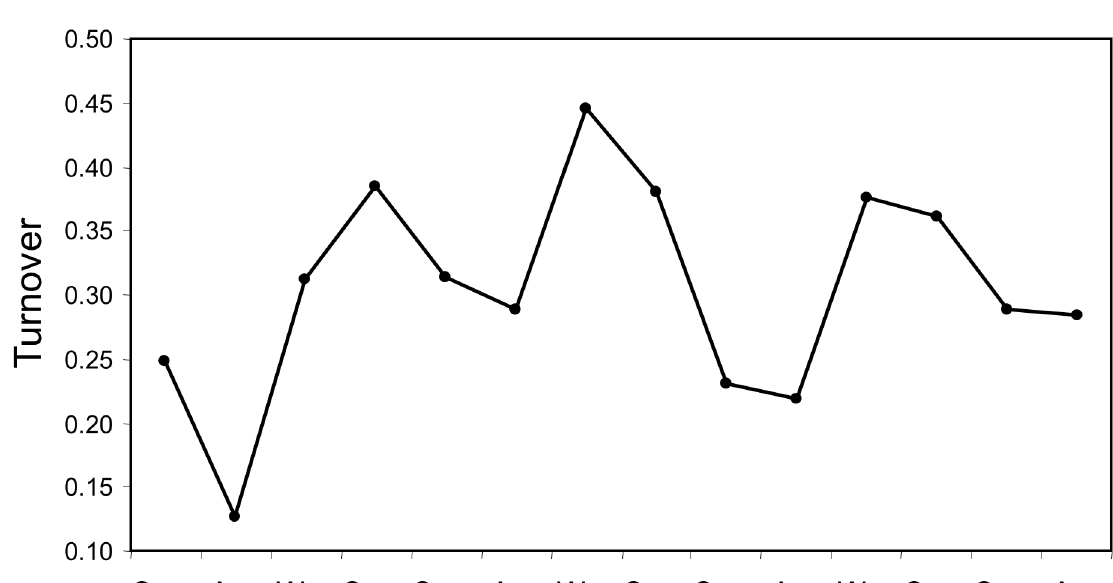
Fig 4. Turnover of the phytoplankton assemblage over the study period. Values shown represent changesin the taxonomic compositionbetweentwo consecutive seasonalperiods. Sp: winter to spring; Su: spring to summer; A: summer to autumn; W: autumn to